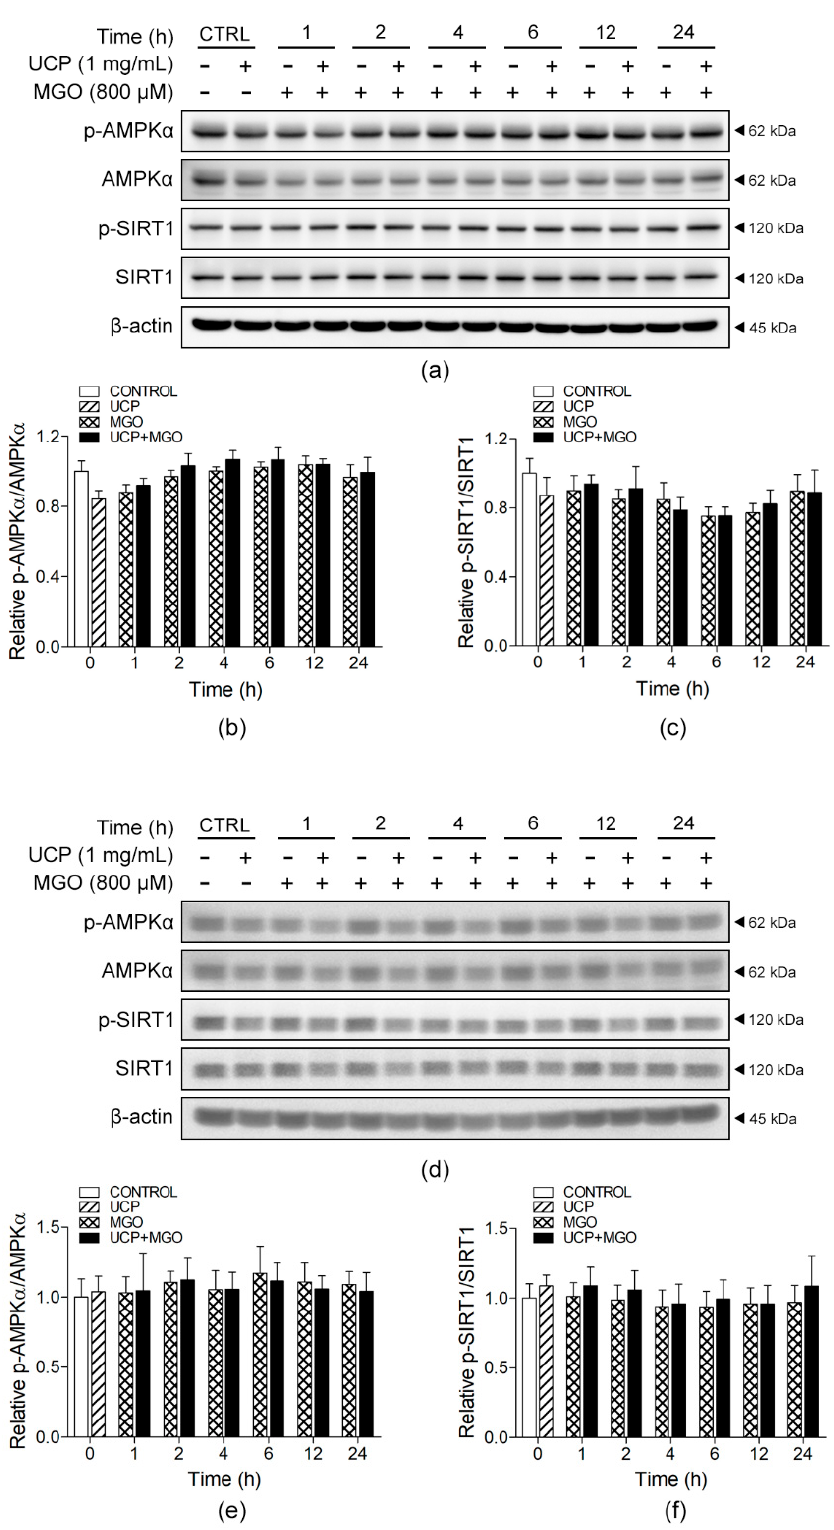
Figure 8. Effects of UCP pretreated on MGO-induced autophagy in high and low glucose DMEM media. ( a ) Representative Western blot protein bands of cell lysates obtained from high glucose culture showing ( b ) p-AMPK α /AMPK α ratios and ( c ) p-SIRT1/SIRT1 ratios. ( d ) Representative Western blot protein bands of cell lysates obtained from low glucose culture showing ( e ) p-AMPK α /AMPK α ratios and ( f ) p-SIRT1/SIRT1 ratios. Data are presented as mean ± SEM.